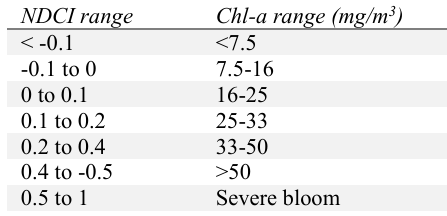
Table 1. Qualitative comparison between NDCI